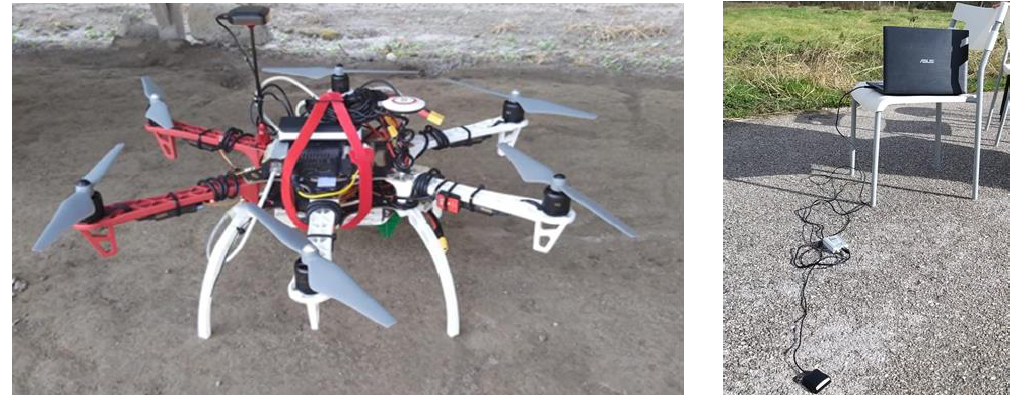
Figure 1. Multicopter-UAVs (M-UAV) radar imaging system: (left) M-UAV hexacopter with onboard equipment [21]; (right) ground-based Global Positioning System (GPS) station [21].